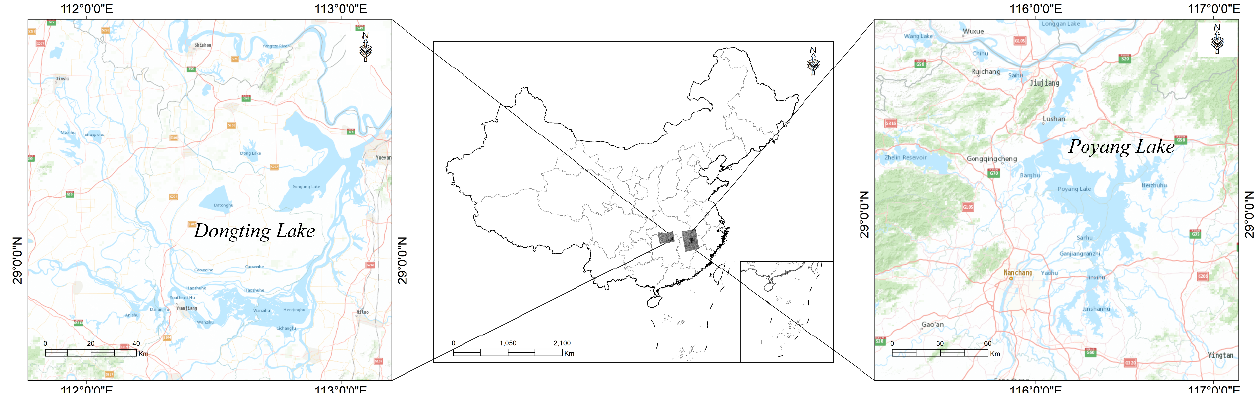
Figure 1. The locations of the study areas. Sentinel-1 data are used to configure the study areas.